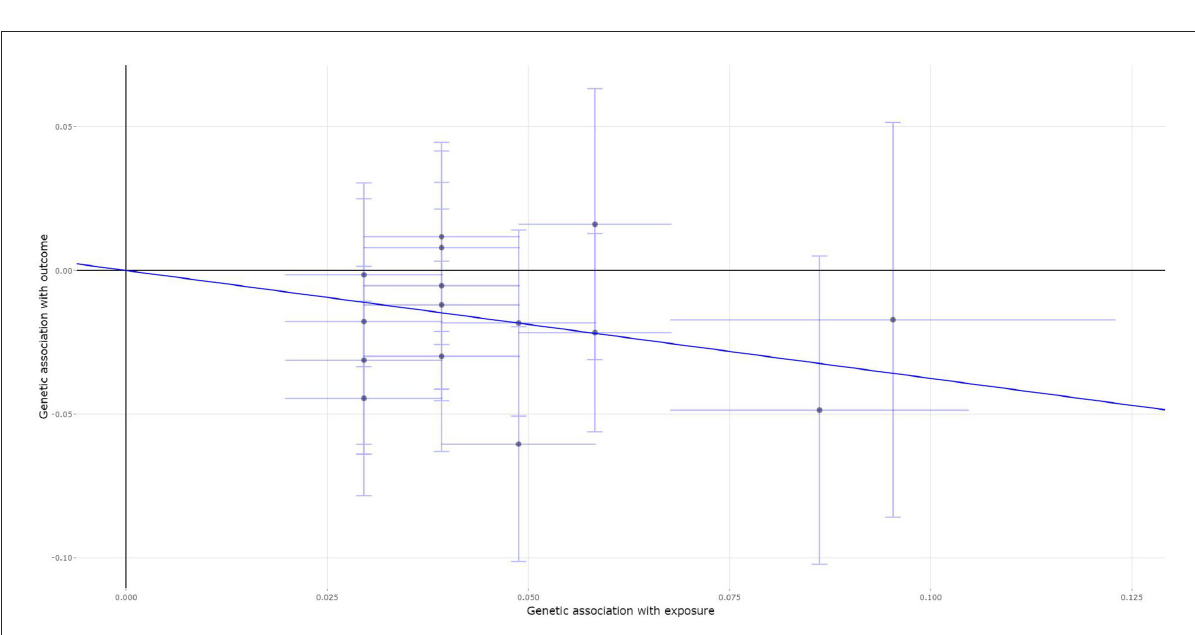
independent of smoking, drinking, and obesity, but dependent of